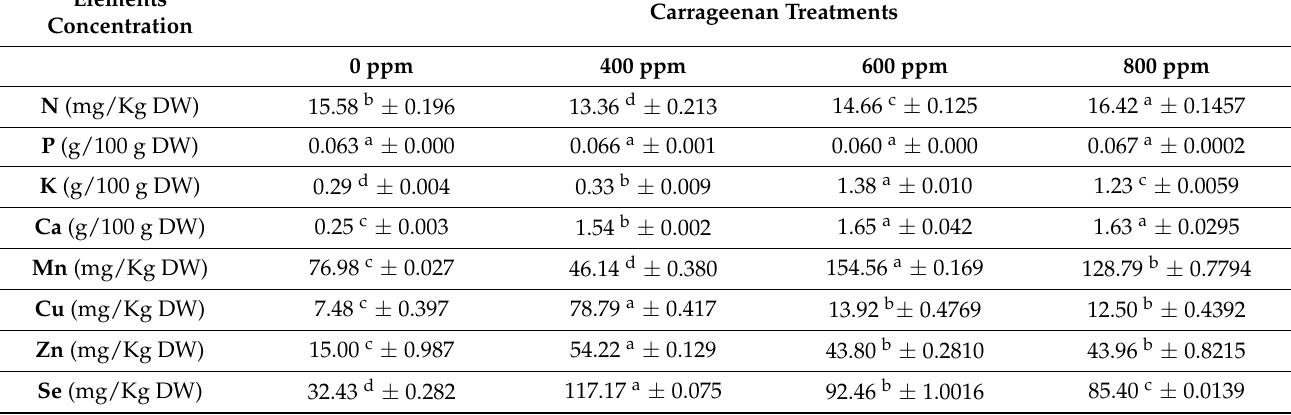
Table 2. Effect of κ -carrageenan on content of elements in Catharanthus roseus .